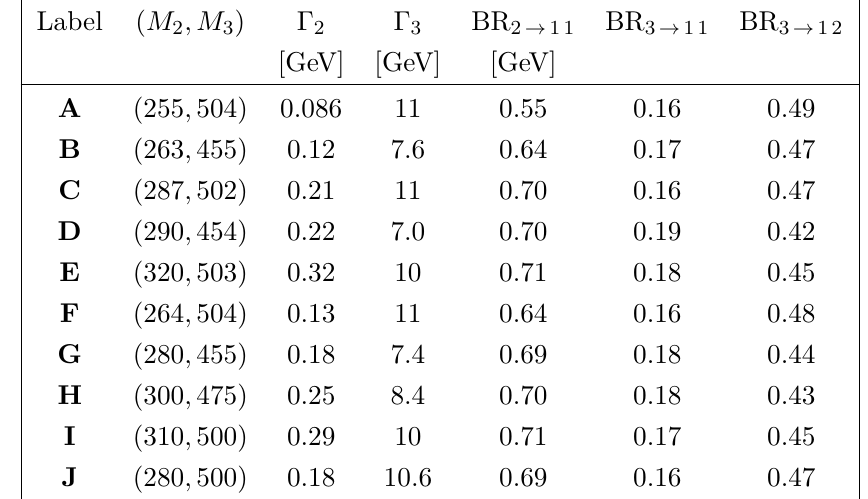
Table 5 . The total widths and new scalar branching ratios for the parameter points considered in the analysis. For the SM-like h considered. The other input parameters are specified in table 1. The on-shell channel h is kinematically forbidden for all points considered